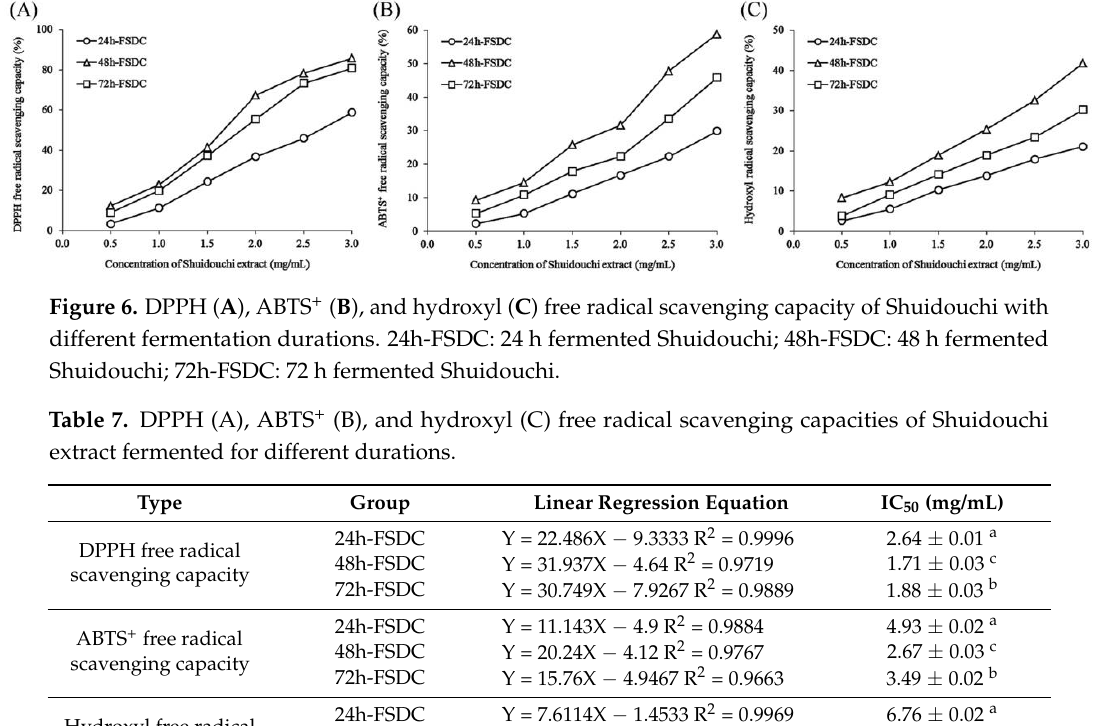
Values presented are the mean ± standard deviation. a–c Mean values with different letters in the same row are significantly different ( p < 0.05). 24h-FSDC: 24 h fermented Shuidouchi; 48h-FSDC: 48 h fermented Shuidouchi; 72h-FSDC: 72 h fermented